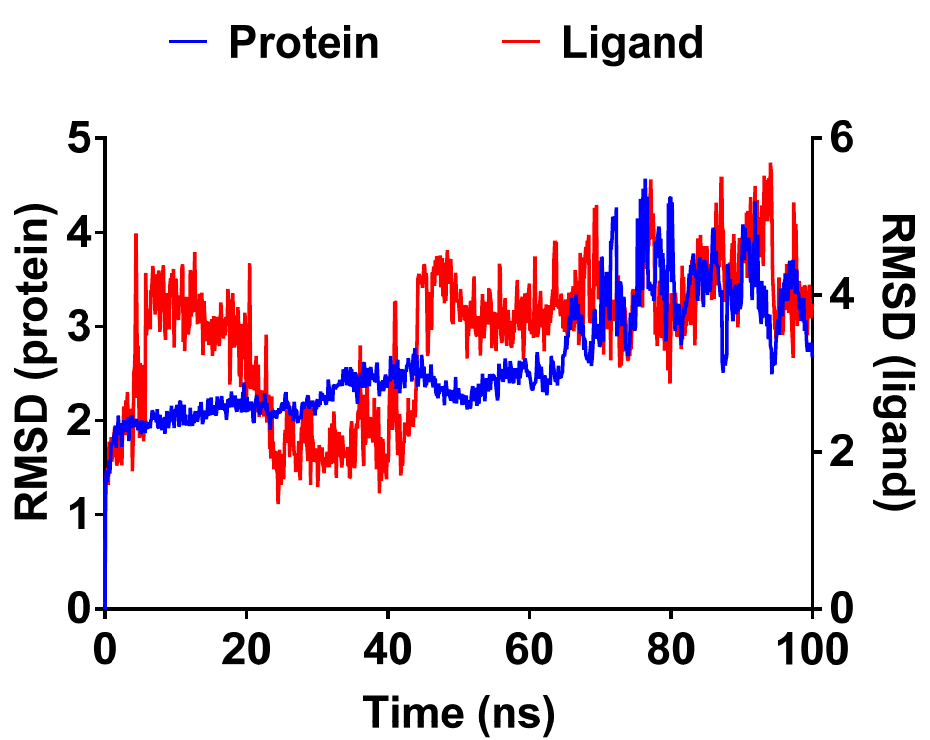
Figure 3. RMSD of the C α backbone of human COX2 receptor and MAS-1696 ligand observed during the 100 ns MD simulation.